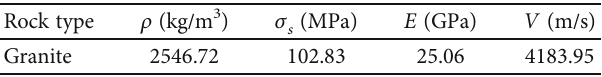
Figure 1: The components and appearances of granite specimens at room temperature. Table 1: The basic physical and mechanical properties of granite